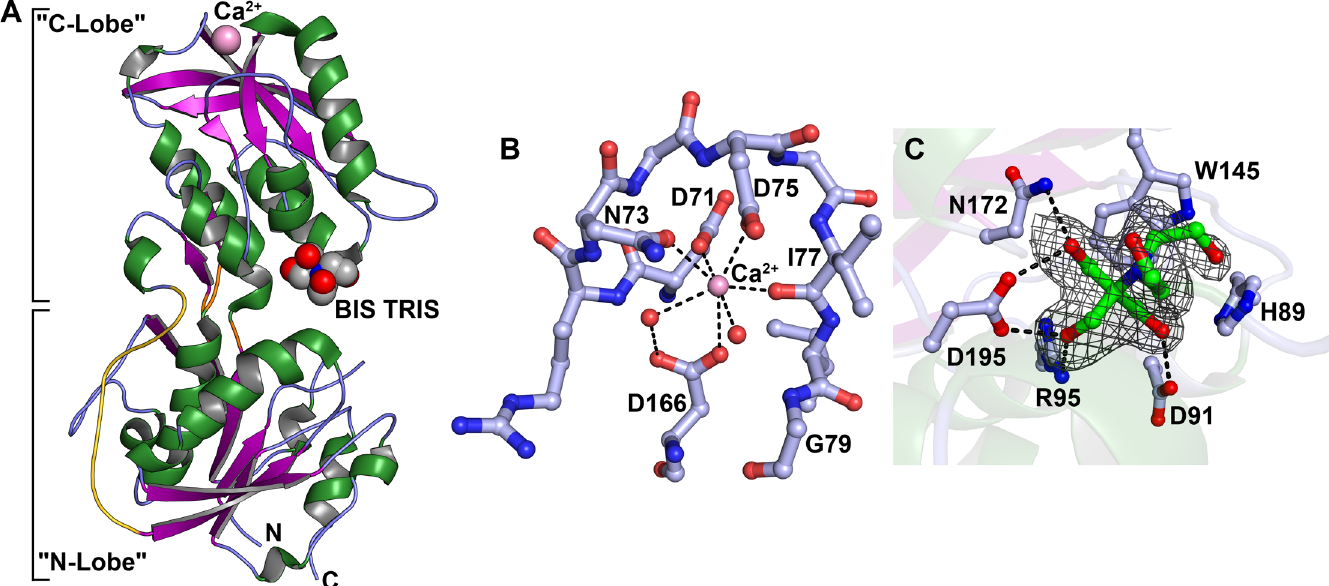
Fig 1. Structural aspects of TpMglB-2. (A) The overall structure. Shown in ribbons representation is the overall crystal structure of TpMglB-2. Helices (either α - or 3 10 ) are shown in green, β -strands are purple arrows, and regions without regular secondary structure are light blue. The three canonical hinge regions are colored orange. The adventitiously bound ligand BIS-TRIS is shown as a group of spheres between the protein ’ s two lobes. Oxygen atoms are colored red, nitrogen atoms blue, and carbon atoms are gray. The Ca 2+ ion bound to the C Lobe is shown as a pink sphere. The span of the protein that forms the fourth hinge region and also comprises the connecting motif not observed in EcMglB (see text) is colored gold. (B) The Ca 2+ -binding site. Residues 71 – 79 are shown, with carbon atoms in light blue, and other atoms colored as described in (A). Water molecules are shown as red spheres. Inner-sphere contacts to the Ca 2+ ion are depicted as black dashes. (C) The BIS-TRIS binding site. A kicked omit mF o - DF c map [43,44] is shown contoured at the 3- σ level and superposed on the refined coordinates of BIS-TRIS. Hydrogen bonds between the protein and the buffer molecule are drawn as black dashes. H89 is shown because it is in van der Waals contact with the molecule. Its ε N atom is about 3.3 Å from the proximal hydroxyl group on the BIS-TRIS, but this distance coupled with the poor geometry make it unlikely that these two atoms are hydrogen-bonded.